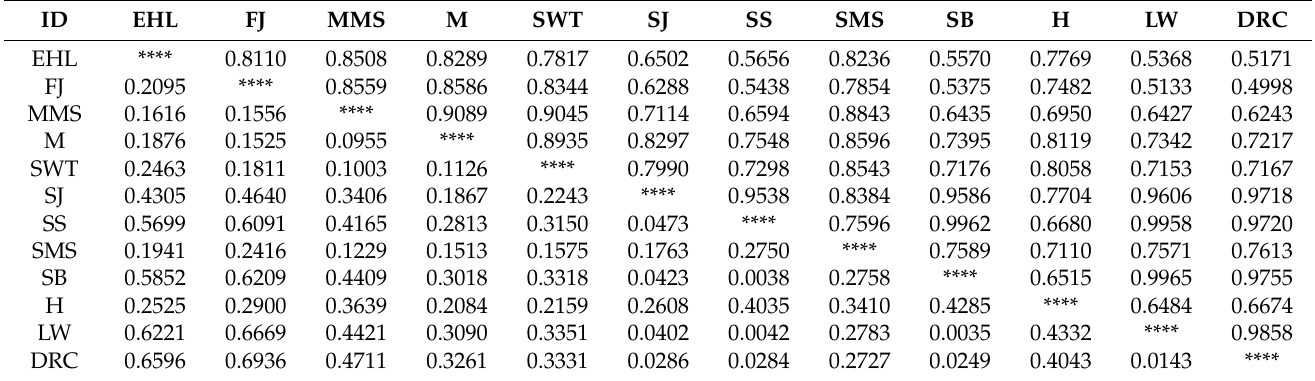
Table 3. Nei’s genetic identity (above diagonal) and genetic distance (below diagonal) between 12 pig populations.